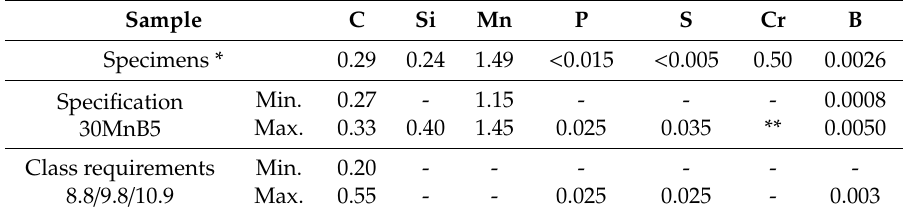
Table 1. Chemical composition check (by weight%) of 30MnB5 bars.